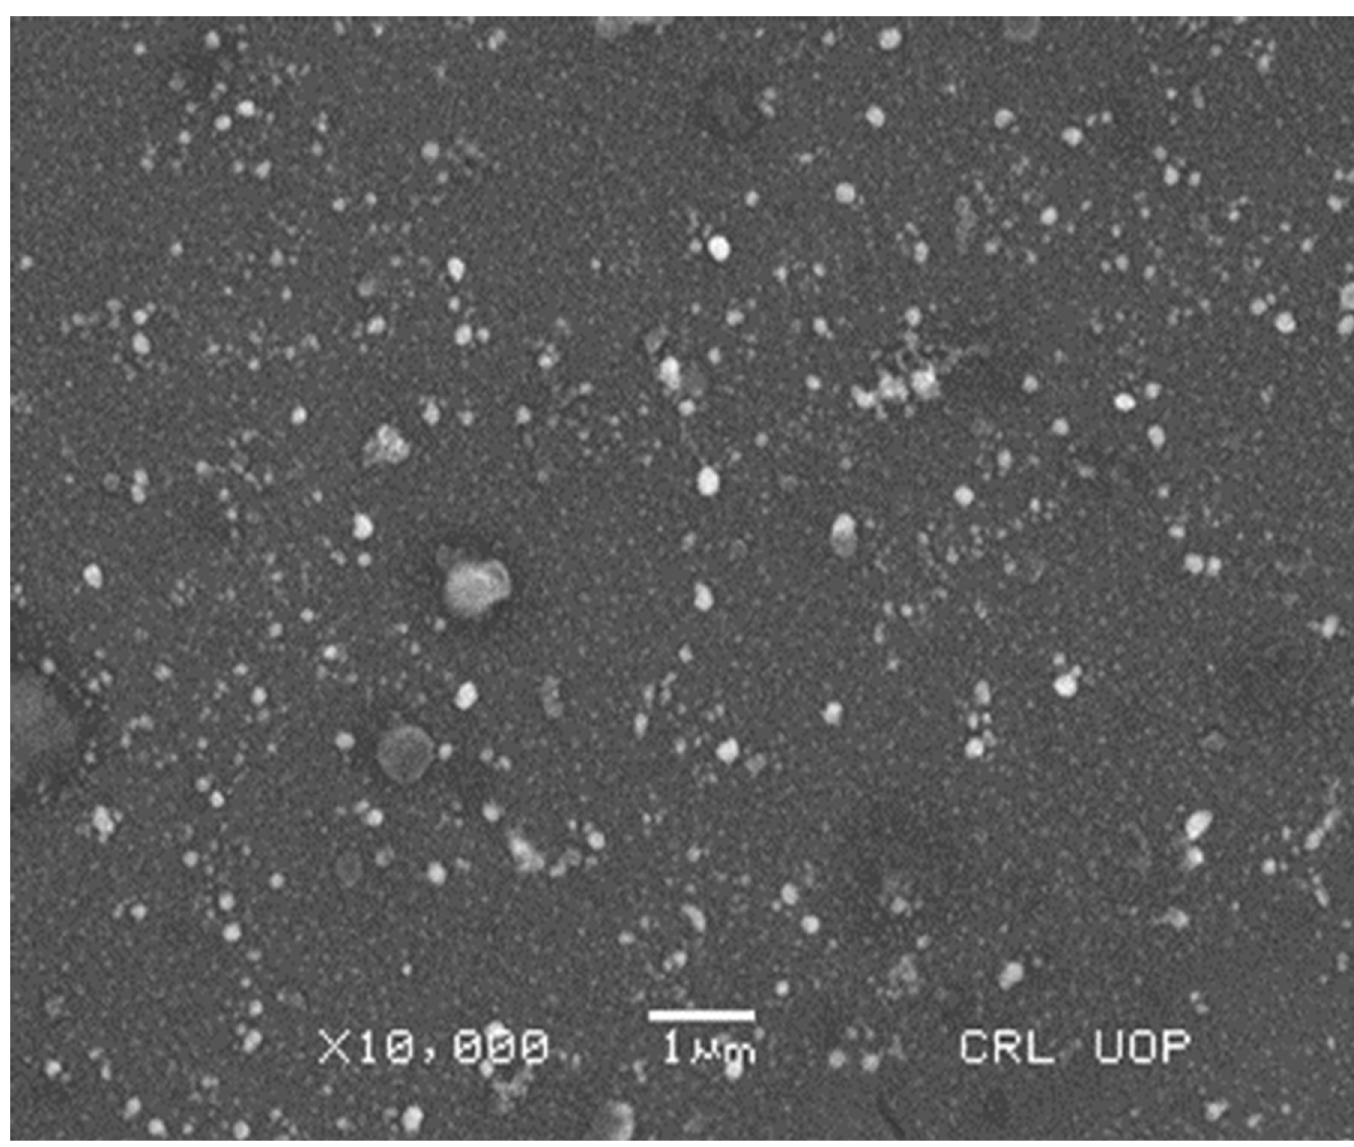
Fig 5. SEM image of green synthesized AgNPs with resolution power of X 10,000.